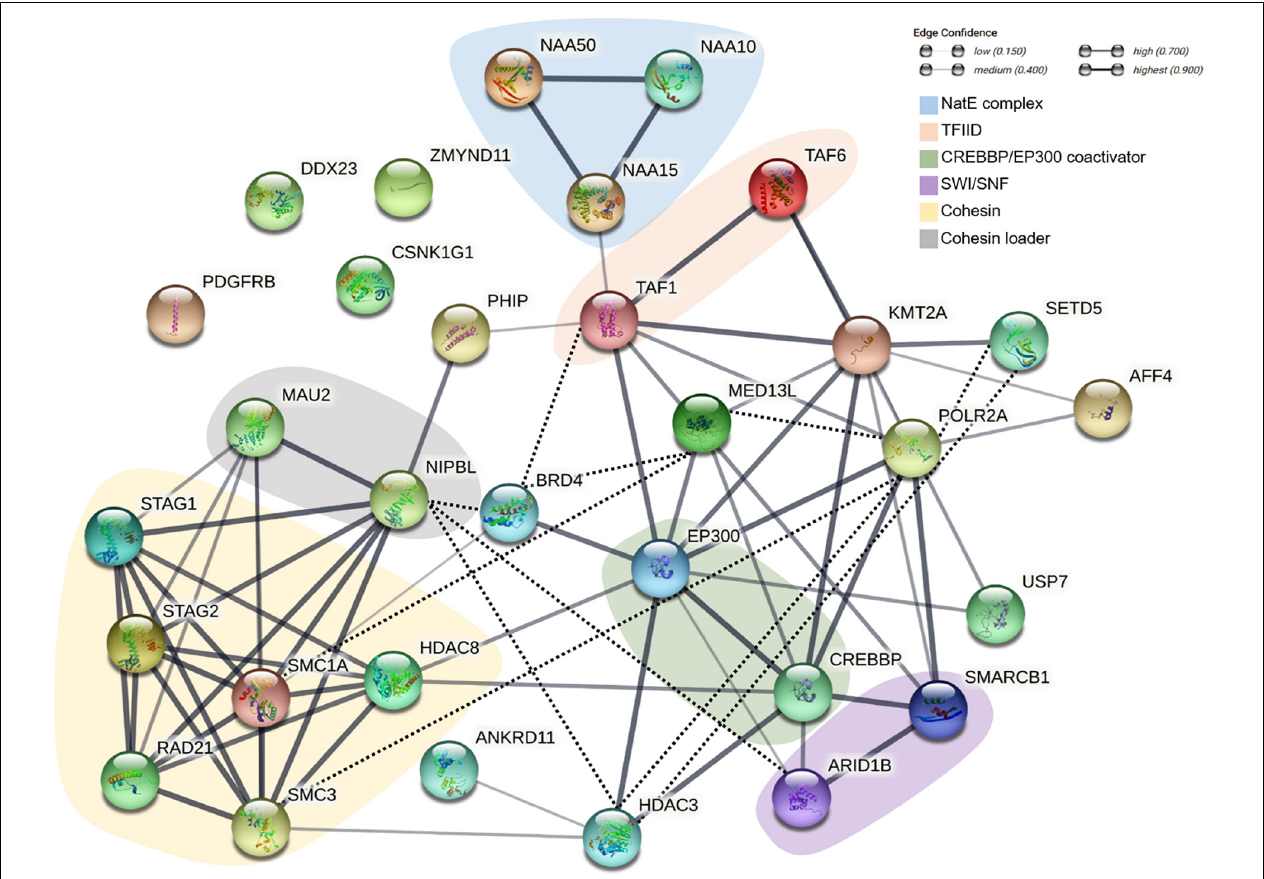
FIGURE 1 | Schematic representation of the functional and physical interactions of the chromatinopathies protein network. The network was generated with the String Database (v. 11.5) (Szklarczyk et al., 2019). Empty nodes represent proteins of unknown 3D structure, while filled nodes indicate proteins with known or predicted protein structure. Line thickness indicates the strength of data support. Interactions were established based on co-expression or data from either curated databases or experimentally determined. The network was subsequently manually curated (dotted black line) based on more recent literature.